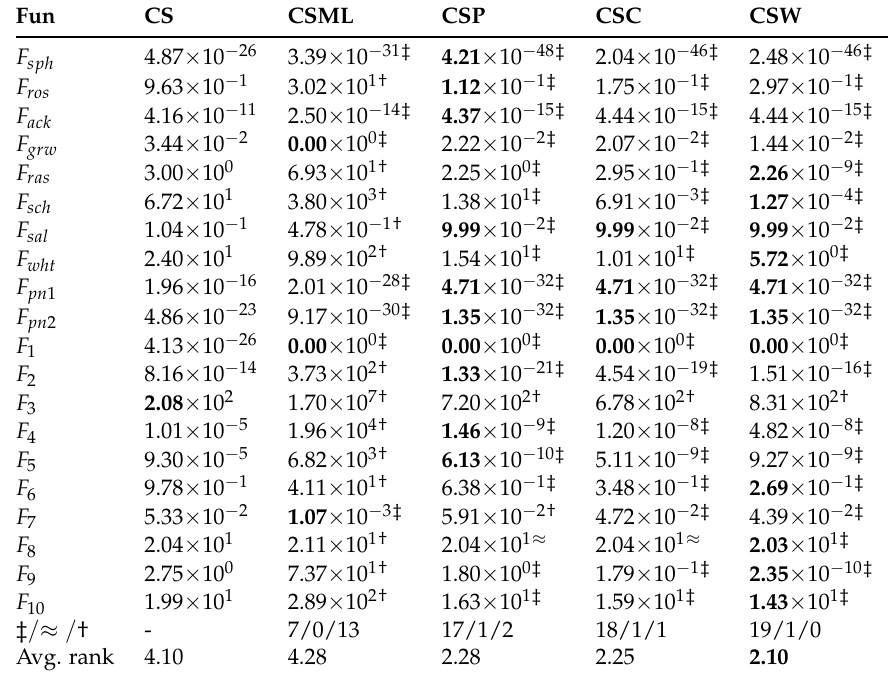
Table 3. Comparisons between CS and four randomness-enhanced CS algorithms at D = 10.